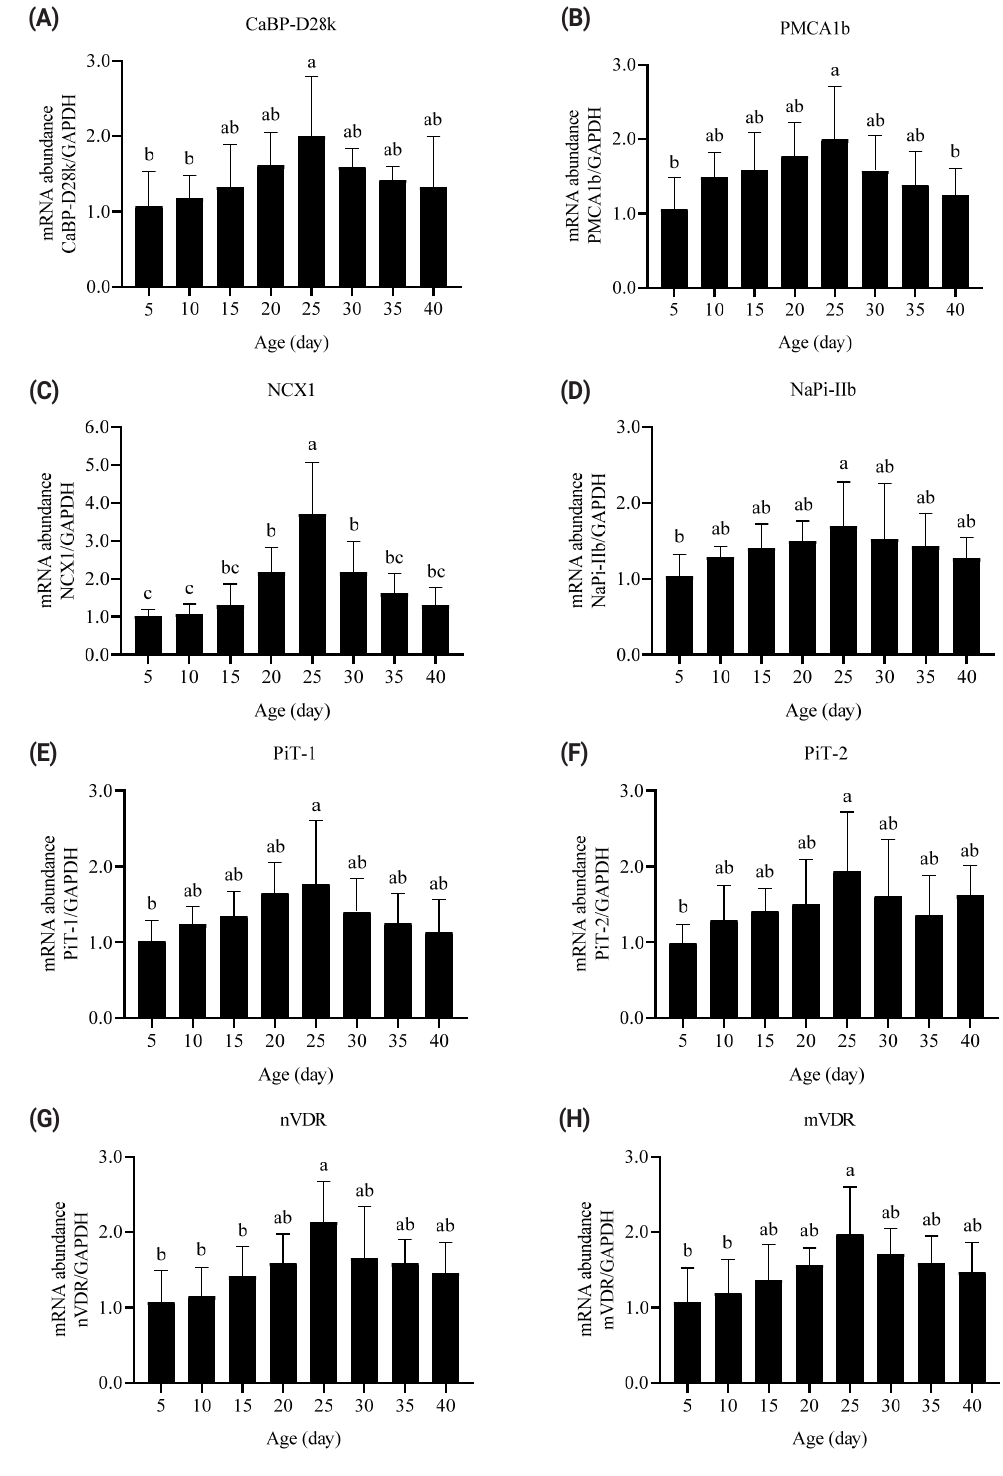
Figure 3. Effects of age on the mRNA abundances of duodenal CaBP-D28k (A, quadratic p = 0.002), PMCA1b (B, quadratic p<0.001), NCX1 (C, quadratic p<0.001), NaPi-IIb (D, quadratic p = 0.003), PiT-1 (E, quadratic p<0.001), PiT-2 (F, quadratic p = 0.034), nVDR (G, quadratic p<0.001), and mVDR (H, quadratic p = 0.002) in broilers from 5 to 40 days. The values are the means of eight broilers (n = 8) and presented as mean±standard deviation. a-c Values with different superscripts are significantly different (p<0.05). CaBP-D28k, calcium-binding protein 28-kDa; PMCA1b, plasma membrane calcium ATPase 1b; NCX1, sodium-calcium exchanger 1; NaPi-IIb, IIb sodium-phosphate cotransporter; PiT-1, inorganic phosphate transporter 1; PiT-2, inorganic phosphate transporter 2; nVDR, nuclear vitamin D receptor; and mVDR, membrane vitamin D receptor.